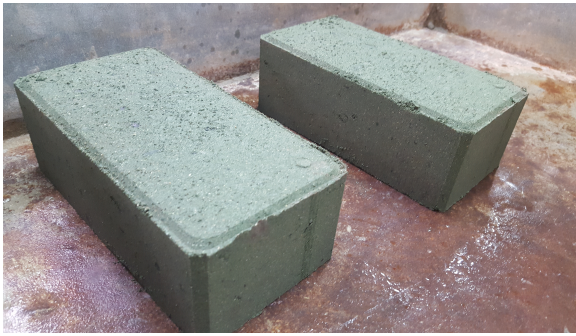
Figure 5: Final product of colored ornamental bricks containing recycled